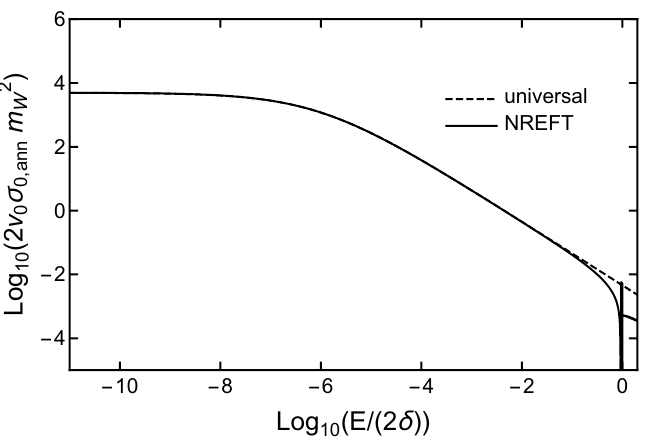
Figure 14 . Log-log plot of the neutral-wino-pair annihilation rate 2 v 0 (cid:27) 0 ; ann at the unitarity mass M (cid:3) = 2 : 39 TeV as a function of the energy E : NREFT (solid curve) and the universal approximation in eq. (3.20b) (dashed